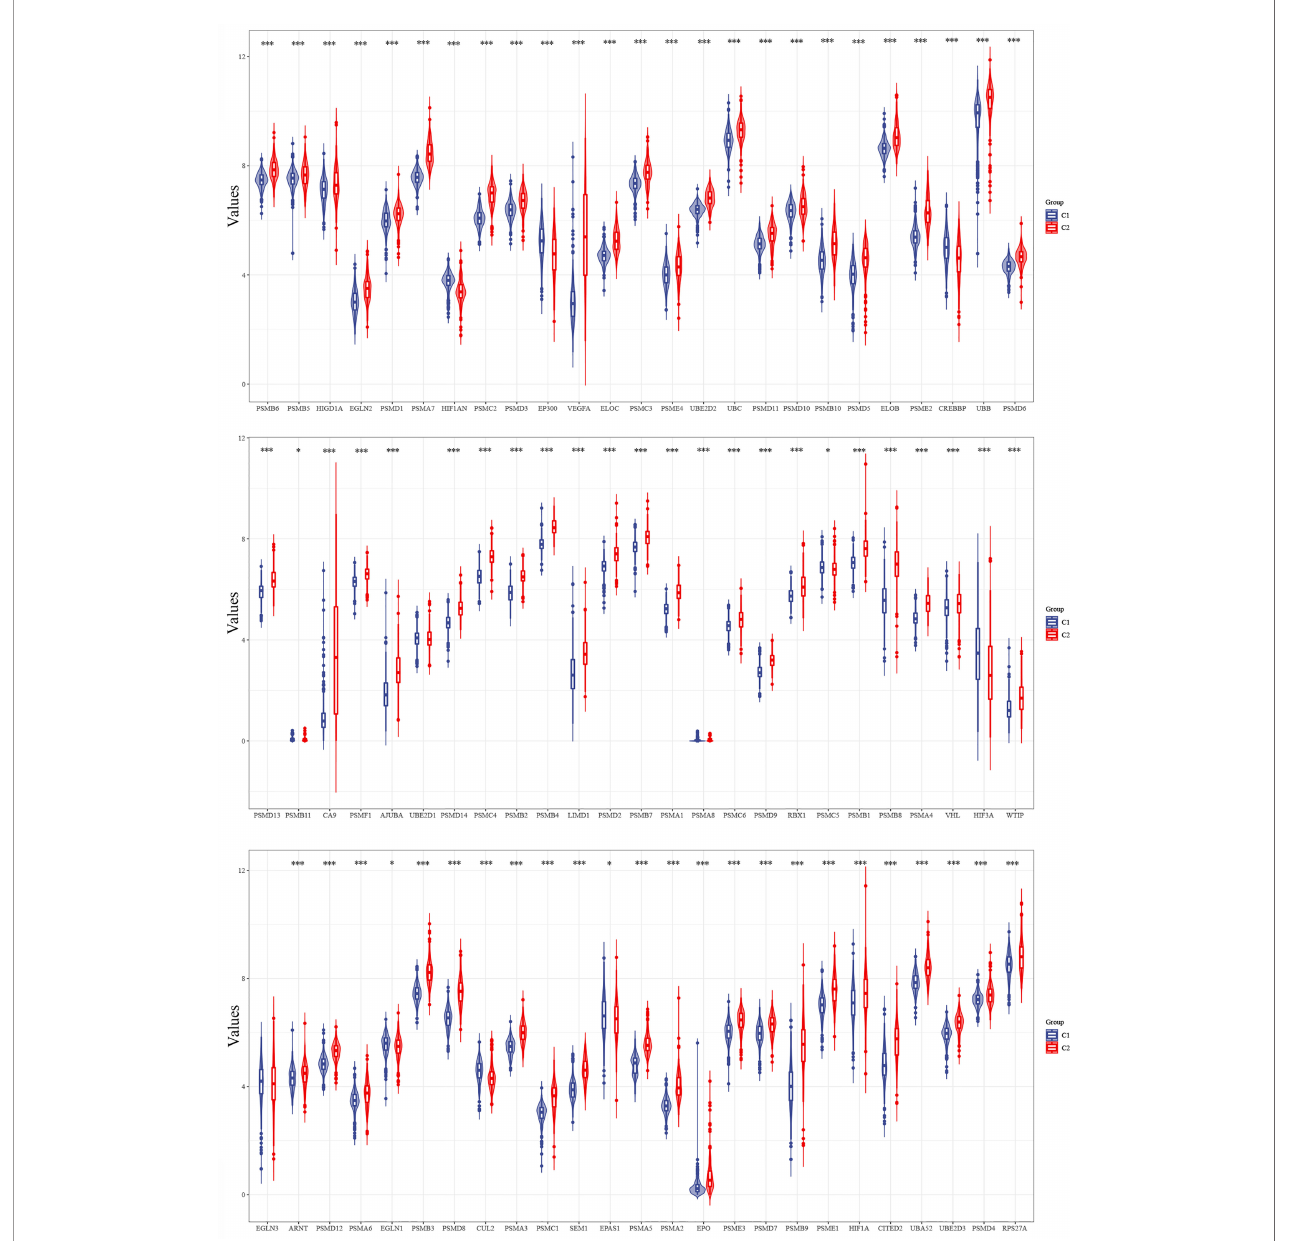
FIGURE 3 | Differences in the expression levels of 75 hypoxia-related genes in the two subgroups (*p < 0.05, ***p <